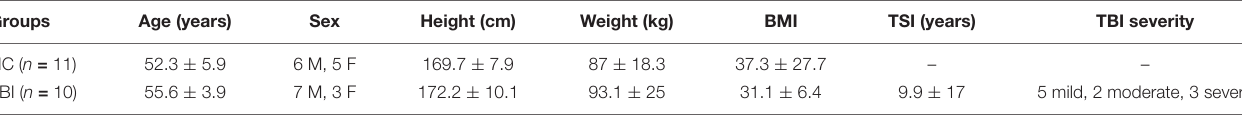
TABLE 1 | Demographics for the study participants with data reported in terms of mean ± standard deviations. Groups